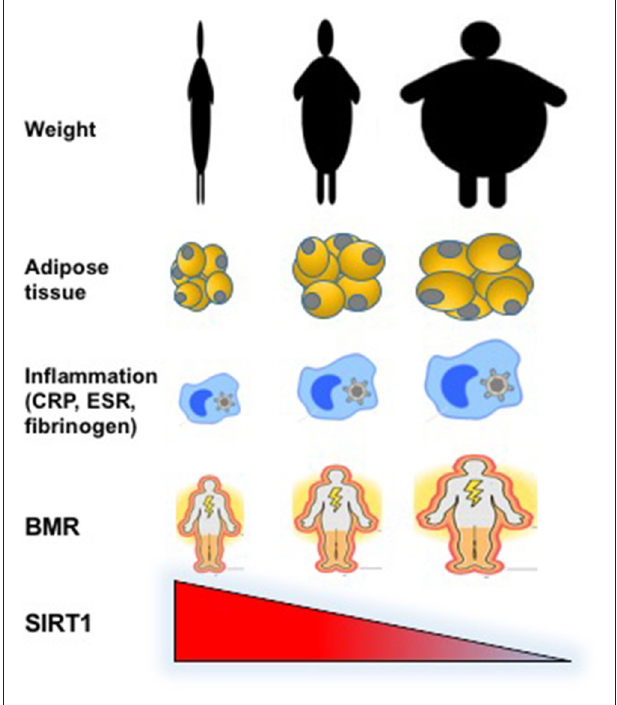
FIGURE 1 | Graphical representation of the inverse relationship between circulating levels of SIRT1 and weight, fat abundance and distribution, inflammatory, and metabolic parameters in underweight, normal weight, and obese